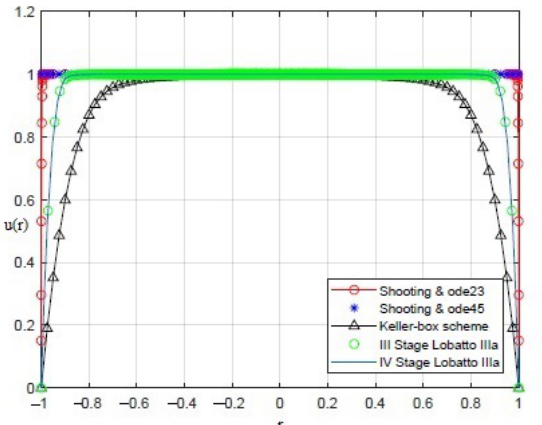
Figure 4. Recovering of u ( r ) for δ = 0.5 and θλ 2 as reported in Tables 1 and 2.